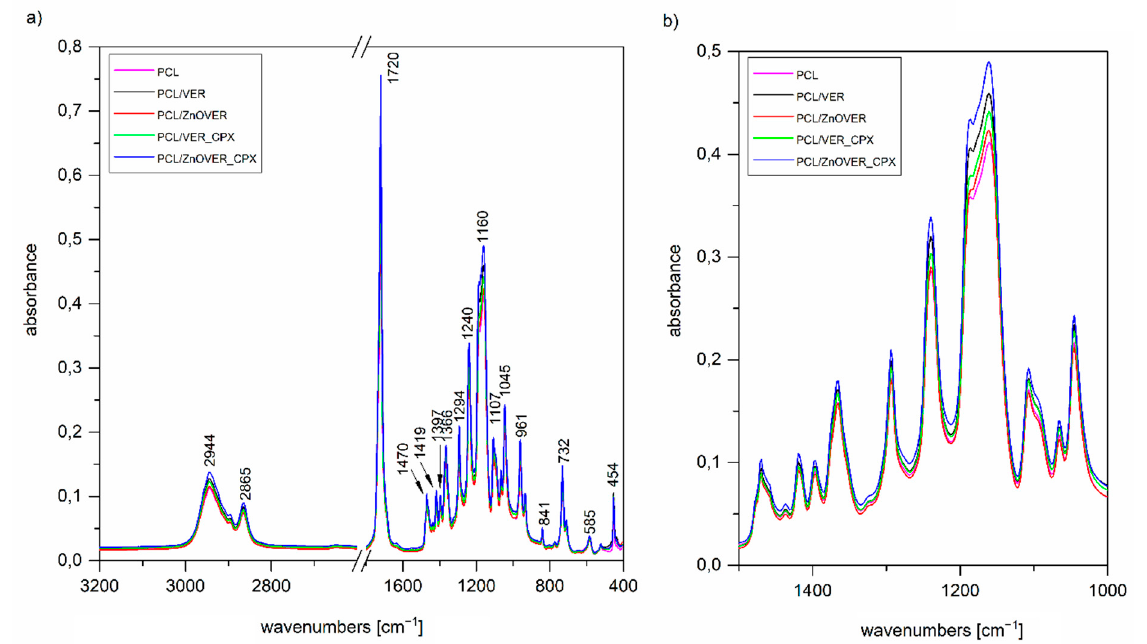
Figure 5. FTIR spectra of ( a ) pure thin PCL film and thin PCL/clay nanocomposite film in the region 3200–400 cm − 1 , ( b ) enlargement in the region 1500–1000 cm − 1 .